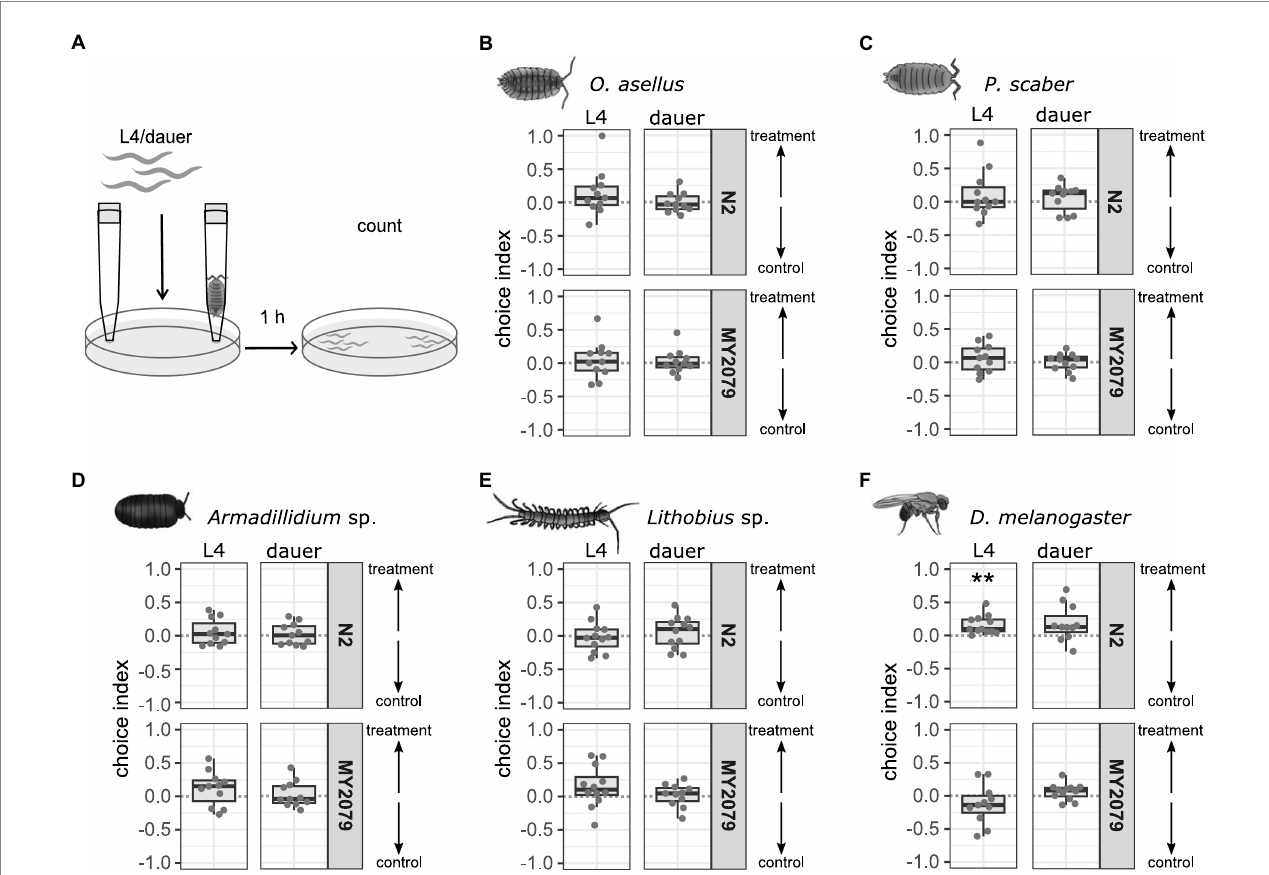
FIGURE 4 Caenorhabditis elegans N2 is attracted to Drosophila melanogaster odorant at L4 stage, but C. elegans does not respond to any other invertebrate odorant. (A) The attraction of C. elegans to invertebrate odorants was determined using live invertebrates fixated in pipette tips at the lid of the assay plates. A positive choice index indicates attraction to the odor of (B) Oniscus asellus ( n = 11), (C) Porcellio scaber ( n = 11), (D) Armadillidium sp. ( n = 11), (E) Lithobius sp. ( n = 11–12), or (F) D. melanogaster ( n = 11–12; treatment), a negative choice index indicates repulsion from the invertebrate (control), a choice index of 0 indicates equal choice of both sides. For comparison of choice indices with 0, the Wilcoxon signed-rank test with false discovery rate (FDR) correction for multiple testing was applied. Data are presented as boxplots with the median as a thick horizontal line, the interquartile range as box, the whiskers as vertical lines, and each replicate depicted by a dot. Significance is designated to ** p < 0.01 (with 30–250 worms per